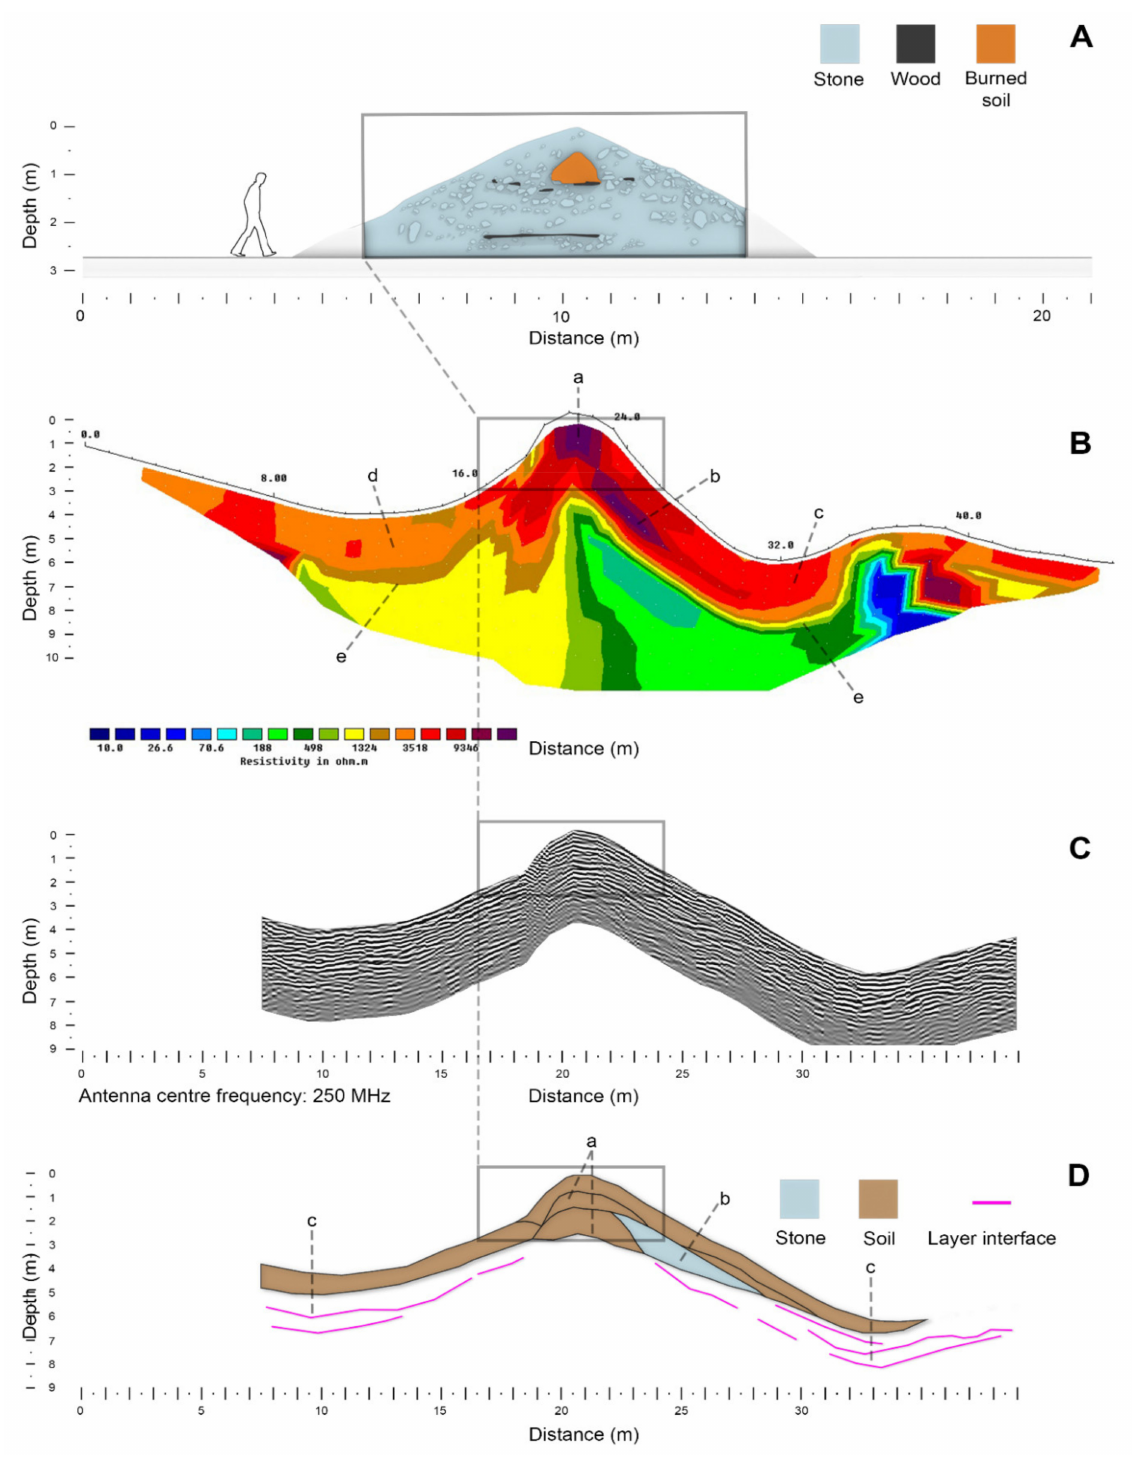
Figure 13. Svät ý Jur-Neštich—Main castle. ( A ): Profile of the hillfort’s fortification based on the results of archaeological excavation ([15], Figure 4). ( B ): Electrical resistivity tomography model in Schlumberger configuration. ( C ): GPR vertical time/depth radarogram from an antenna with 250 MHz centre frequency. ( D ): Interpretation of the GPR